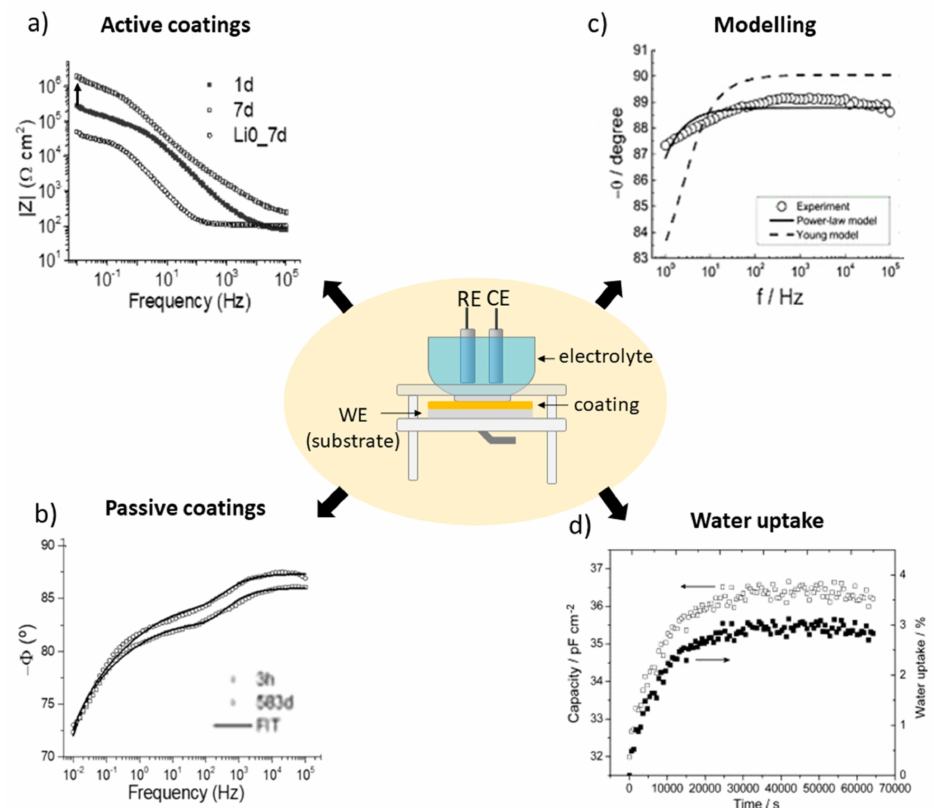
Figure 8. Illustrative scheme of the main applications of electrochemical impedance spectroscopy (EIS) analysis in the field of polymeric anti-corrosion coatings, including ( a ) active coatings, ( b ) passive coatings, ( c ) modelling and ( d ) water uptake calculations. Reproduced with permission of ACS and Elsevier. Adapted from references